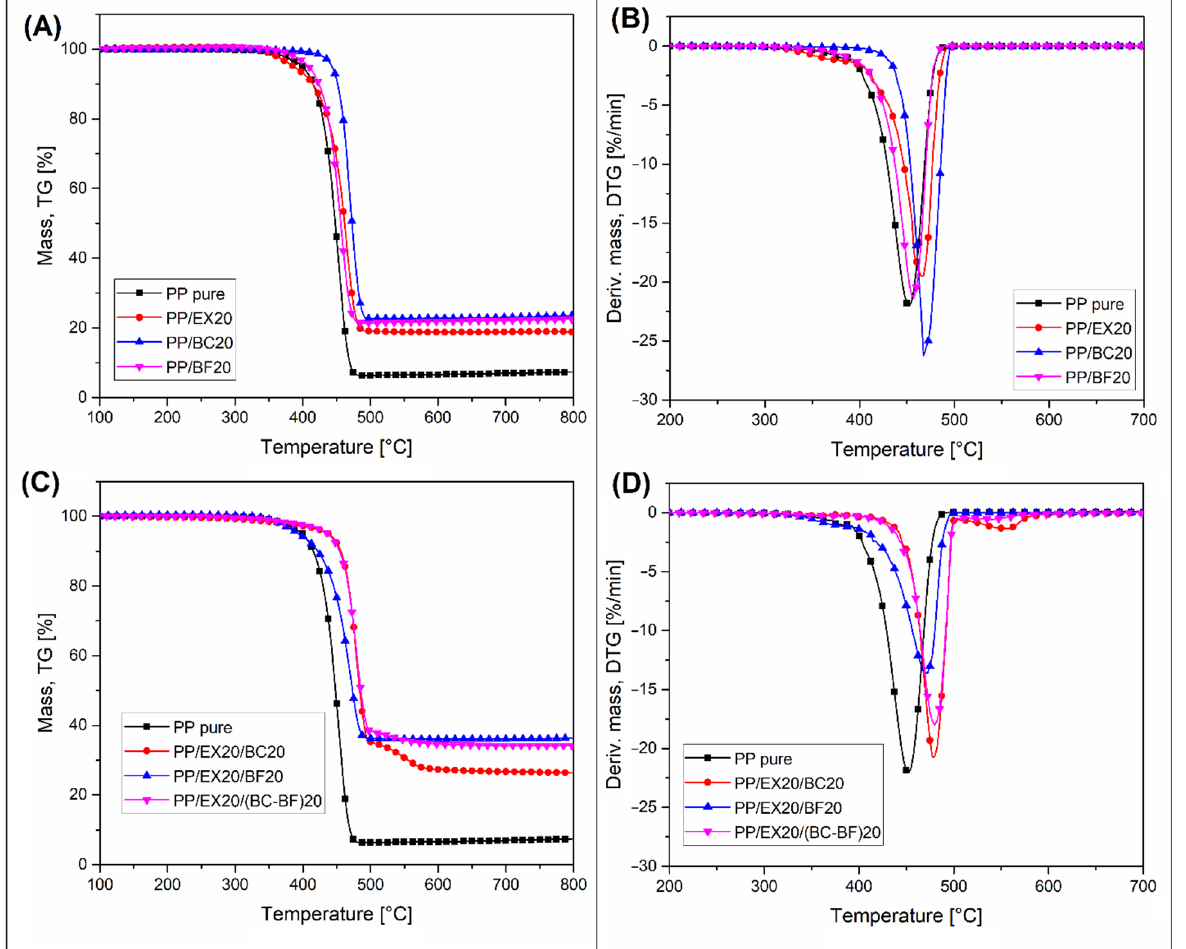
Figure 5. The thermogravimetric (TGA) analysis of PP-based samples. Results are presented in the form of weight loss TG ( A , C ) and derivative weight loss plots DTG ( B , D ).